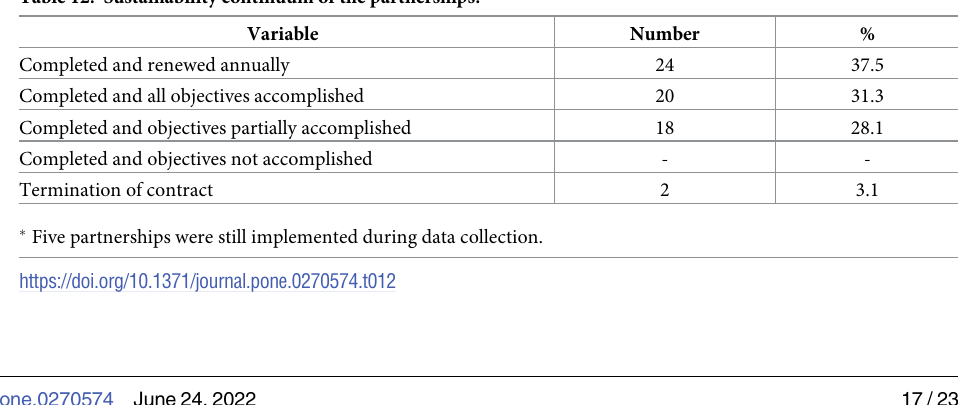
Table 12. Sustainability continuum of the